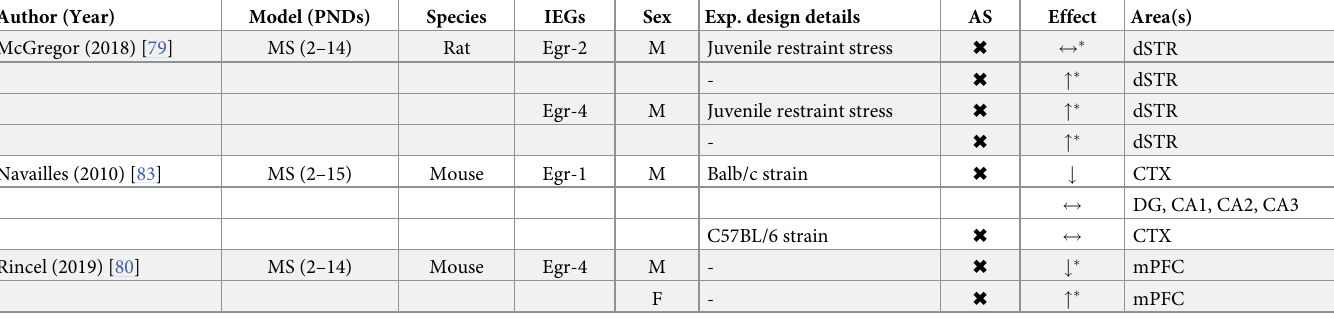
performed subgroup analyses to investigate the experience of additional hits, i.e. an additional negative life event. Of note, the control and experimental groups always differed only in the presence/absence of ELA. Therefore, in the ‘additional hits’ comparisons, both control and ELA animals experienced multiple negative life events. This was important for cFos expression after acute stress, where the effects of ELA were pronounced only in synergy with additional